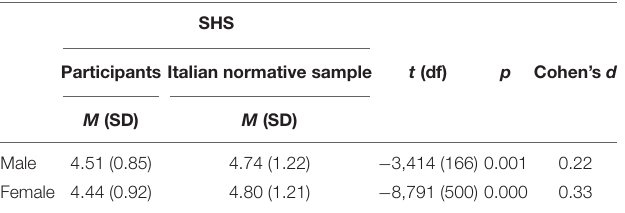
TABLE 3 | Subjective Happiness Scale (SHS) comparison between the average values of the participants and the average values of the Italian normative sample. SHS